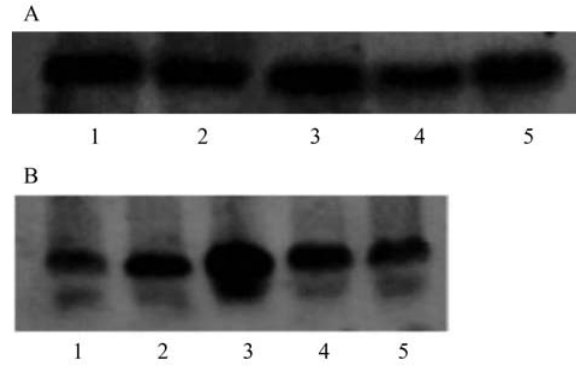
Figure 4 - Northern blot results. A) 18s ribosomal gene B) D. melanogaster hsp83 gene. Total RNA was isolated from third-instar larvae raised on banana-agar media with or without diphenyl diselenide and with or without heat shock. 1) banana-agar media containing no di- phenyl diselenide (control); 2) banana-agar media containing 300 μ mol diphenyl diselenide; 3) banana-agar media containing no diphenyl disele- nide and heat shocked at 30 °C; 4) banana-agar media containing 300 μ mol diphenyl diselenide and heat shocked at 30 °C; and 5) banana- agar media containing 800 μ mol diphenyl